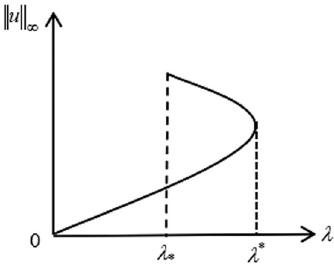
Figure 1: ⊃ - shaped bifurcation starting from ( 0, 0 ) with < < p 0 2